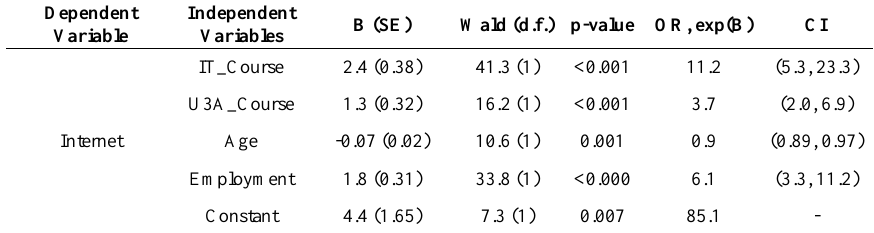
Table 4. Associated factors of the Internet use (N = 432), coefficients of the logistic regression model.